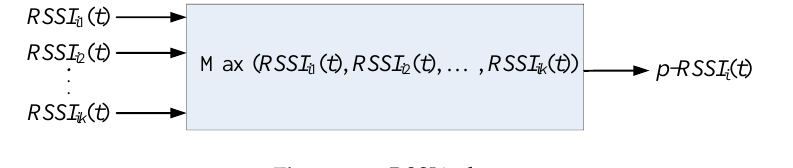
Figure 2. p-RSSI index.